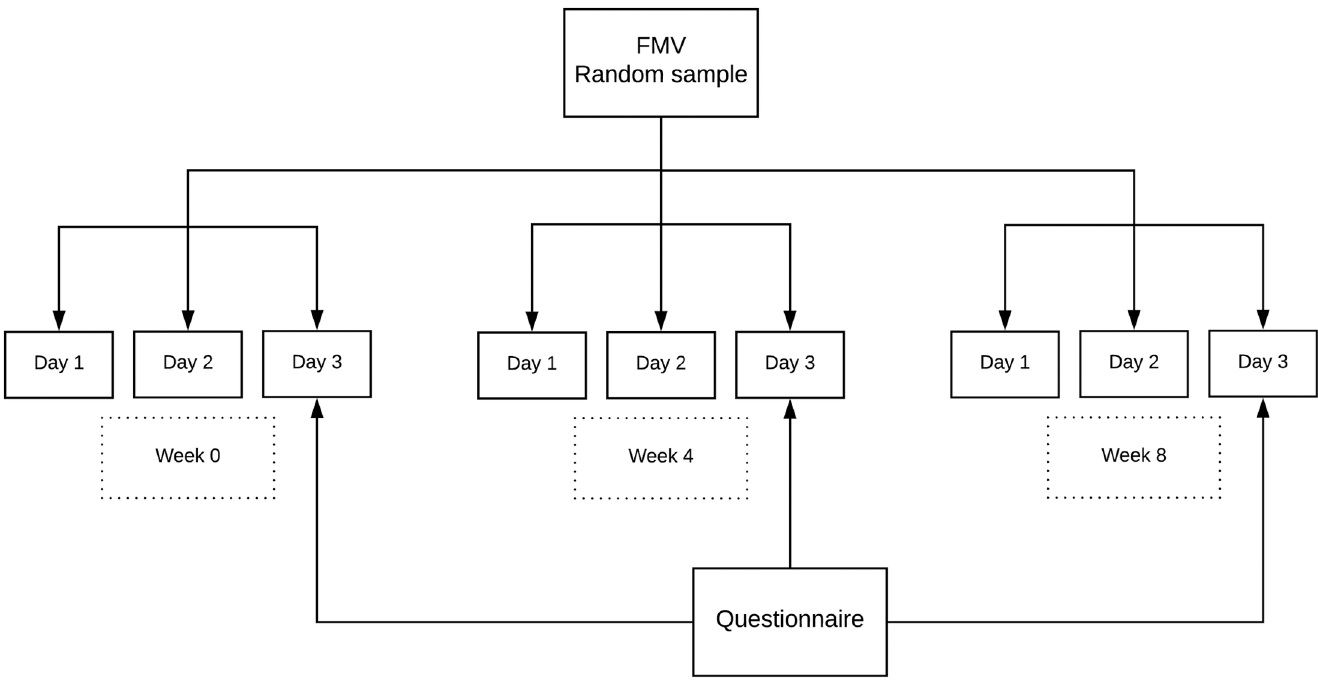
Fig 1. Schedule of data collection.